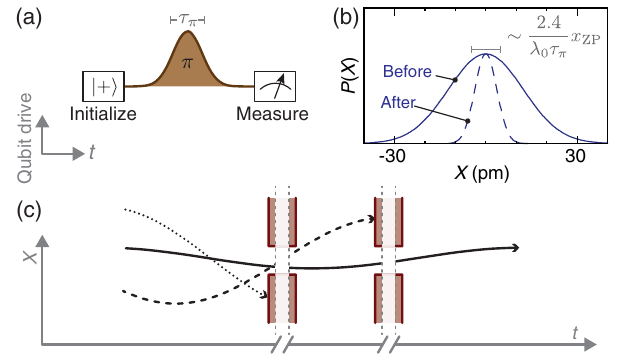
FIG. 2. Cooling the resonator using the qubit. (a) Pulse sequence (see text). Gaussian pulse shaping is chosen for near-optimal filtering. (b) Effect of this sequence, conditioned on the qubit outcome j − i , on an initial mechanical distribution with a thermal distribution ¯ n ¼ 5 . (Burst duration is τ π ¼ 38 ns with λ 0 = 2 π ¼ 4 . 2 MHz.) The pulse sequence has the effect of passing the wave function through a narrow slit. The filter function is obtained by numerically solving the time evolution generated by Eq. (5) with an additional π -pulse term g ð t Þ σ (c) Cartoon showing the effect of two pulse sequences, offset by a quarter of a mechanical period. Only the lowest-energy trajecto- ries (solid line) survive both measurements, effectively cooling the resonator. For the purpose of this cartoon, the duration of the two pulse sequences is compressed; in fact, each pulse sequence lasts for several mechanical periods.